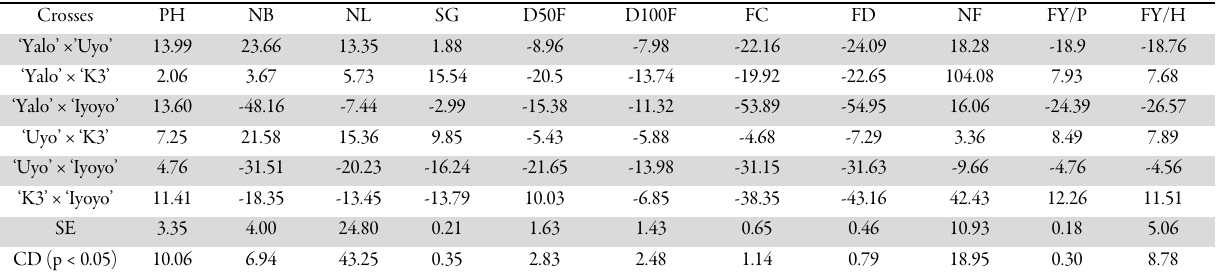
Table 2. Estimates of heterosis (%) in F 1 over the better parents (BP) for 11 agronomic traits of eggplant genotypes Crosses PH NB NL SG D50F